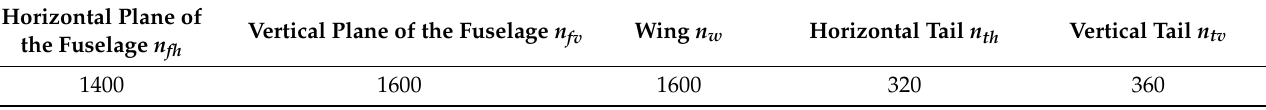
Table 1. The number of vortex lattices on each part of the